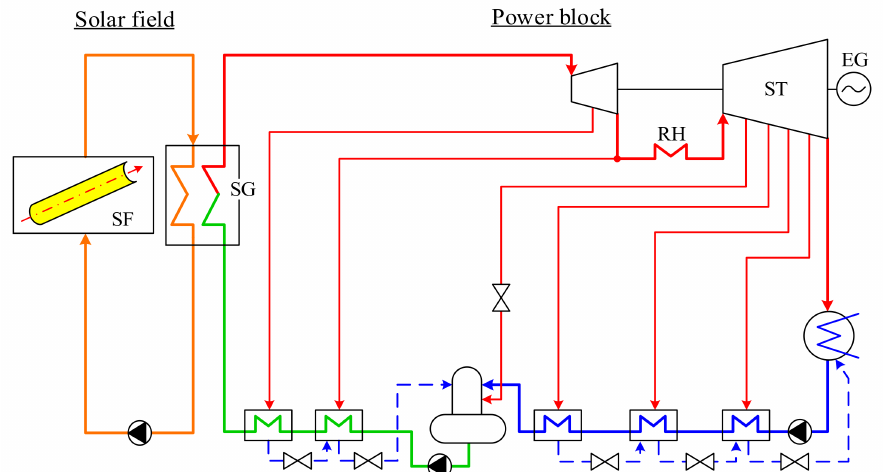
Figure 2. Process flow diagram of the 50 MW CSP plant (Montes’s paper): SF—solar field; SG—steam generator; RH—reheater; ST—steam turbine; EG—electric